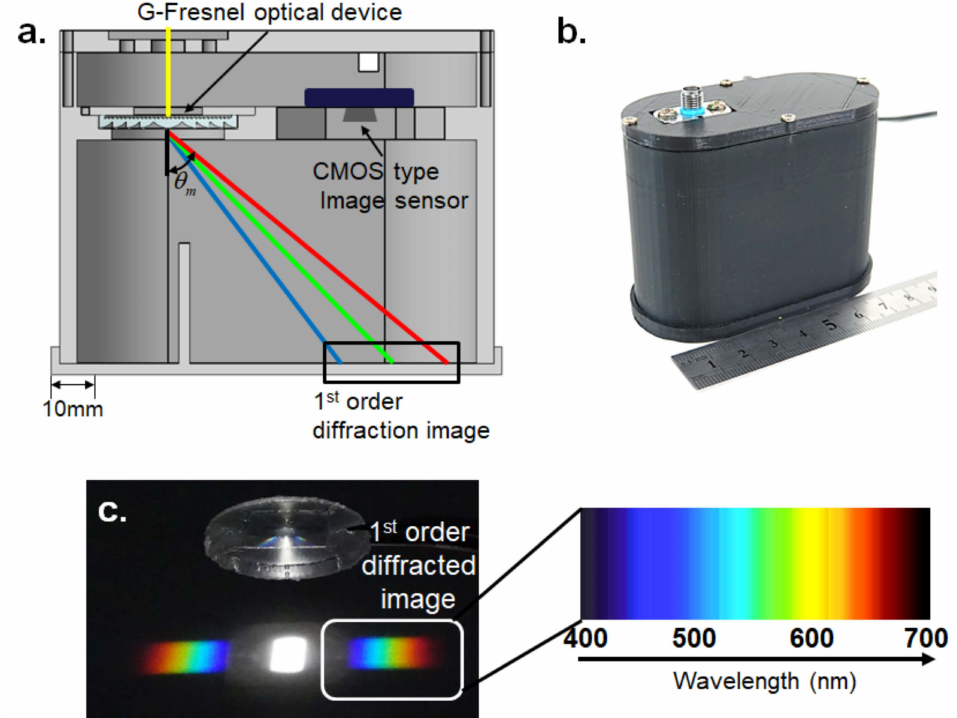
Figure 5. G-Fresnel optical device-based miniature spectrometer ( a ) schematic, ( b ) photograph, and ( c ) the G-Fresnel optical device and spectrum corresponding to white visible